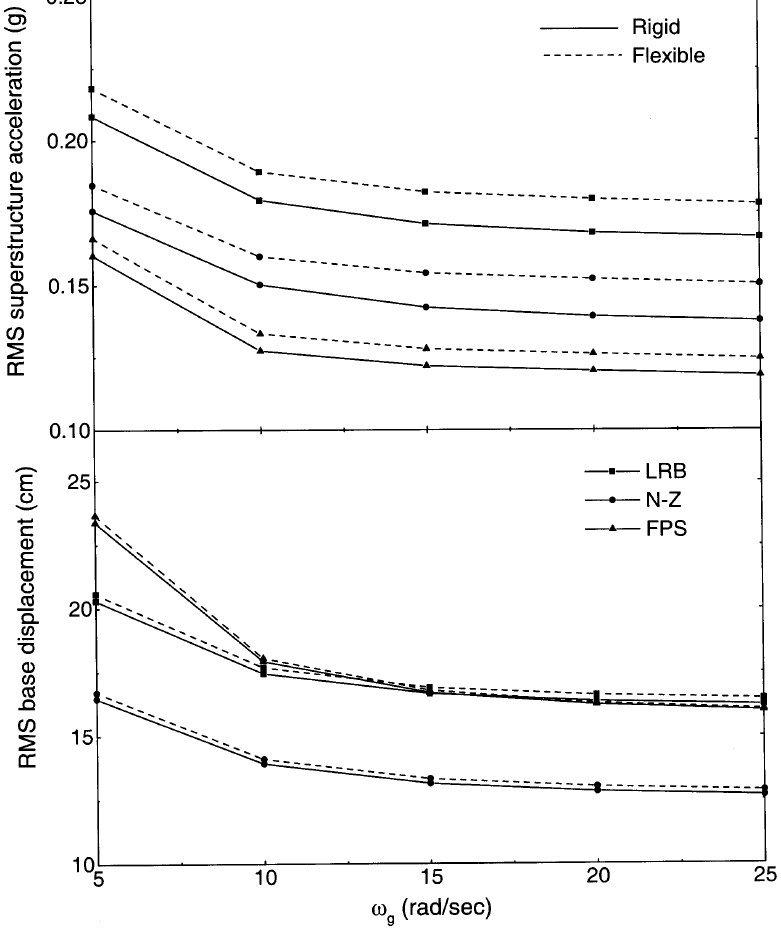
Fig. 10. Effects of soil frequency on the peak response of the base-isolated structure ( T s = 0 . 5